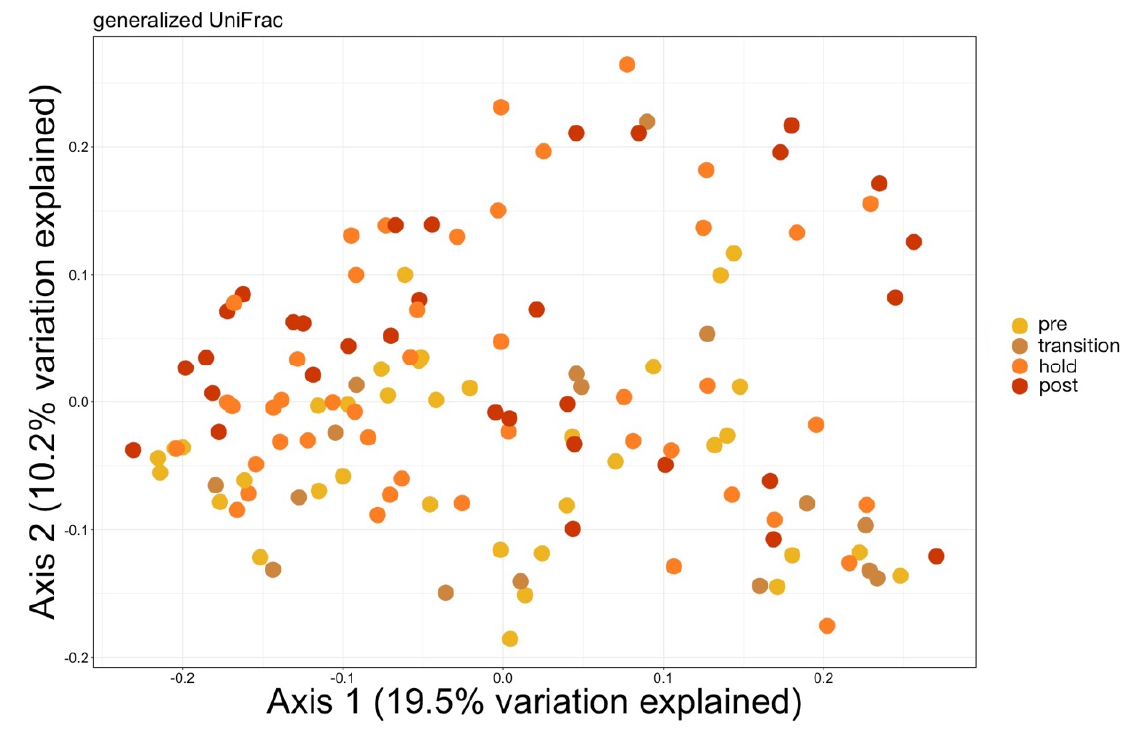
Figure 7. PCoA of the microbial communities from skin samples throughout the water change. To aid visualization, samples are colored by phase opposed to salinity. All phases were significantly difference from each other, with the exception of hold vs. post (PERMANOVA, p < 0.05).